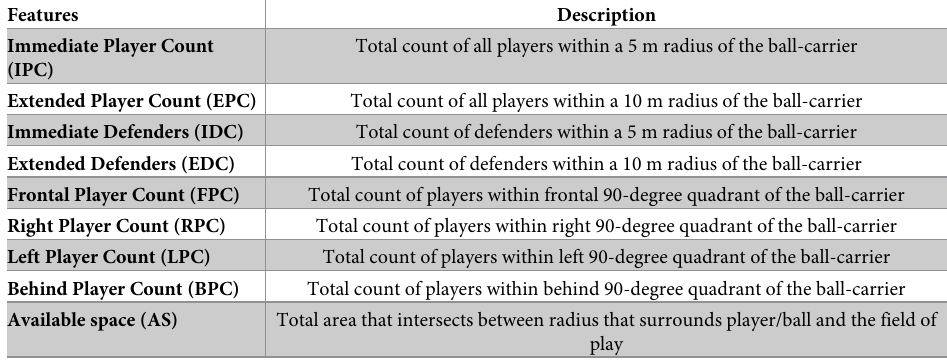
Table 2. Definition of spatiotemporal features for disposal classification